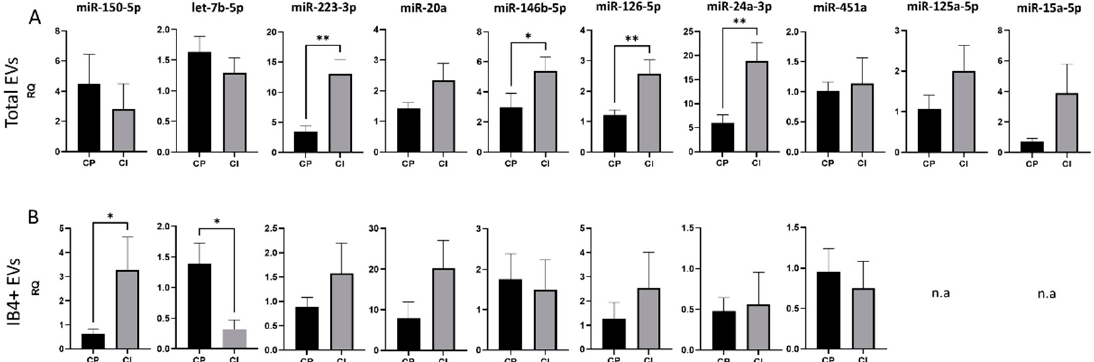
Figure 3. miRNA cargo in total and IB4-positive (IB4+) EVs in the Italian cohort of MS patients. ( A ) RQ of selected miRNA levels in total plasma EVs from CP and CI patients. ( B ) RQ of selected miRNA levels in IB4+ EVs from CP and CI patients. Data were normalized to miR-16-5p and miR- 21-5p, expressed as 2 – ΔΔ Ct . Mann–Whitney test, * p < 0.05, ** p < 0.001